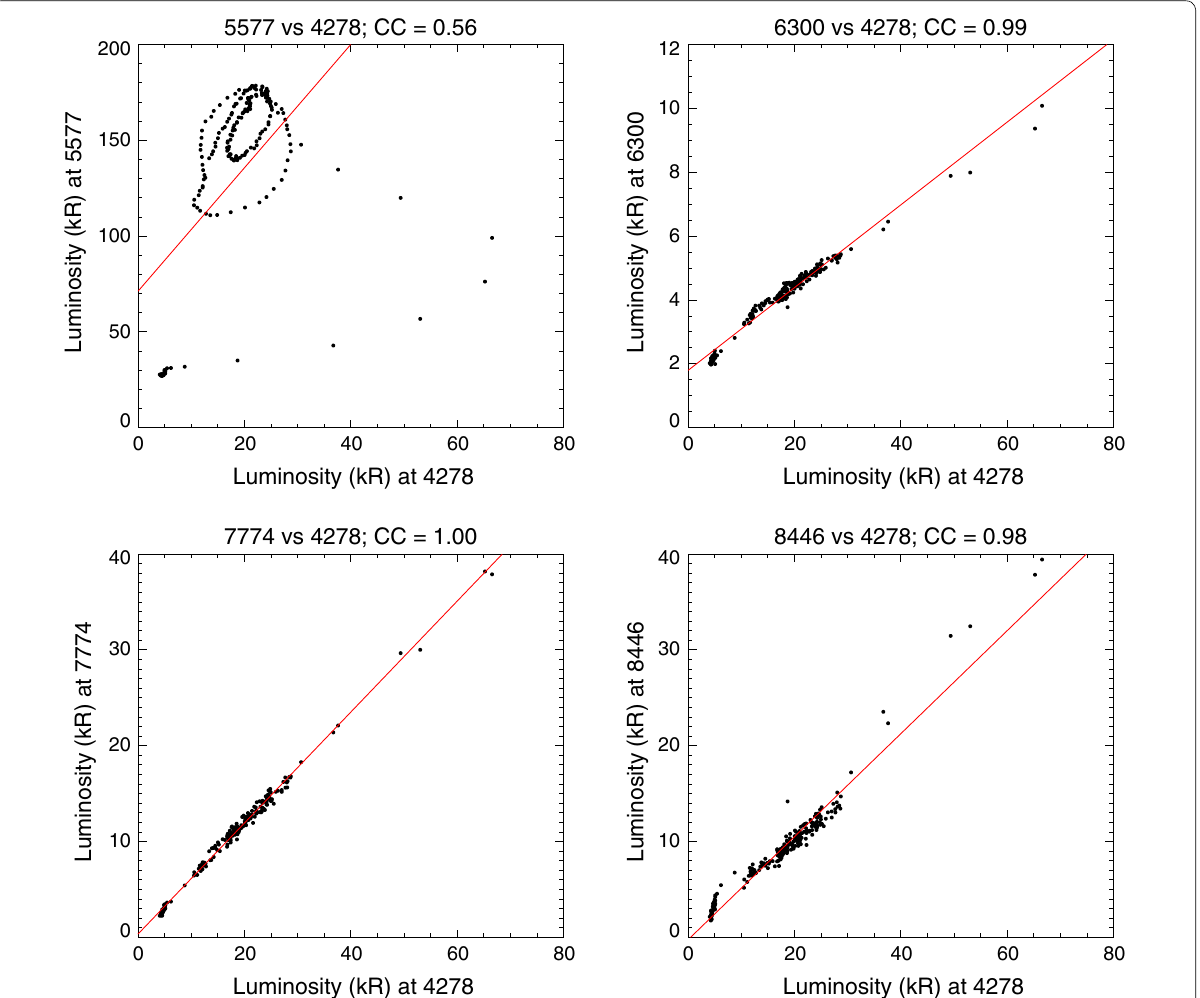
Fig. 8 Scatter plots of auroral intensities (20 Hz data) between 427.8 nm and 557.7 nm (top-left), 630 nm (top-right), 777.4 nm (bottom-left), and 844.6 nm (bottom-right) between 20:16:48 UT and 20:16:59 UT on October 19, 2017. Red solid lines are fitted lines determined with the least